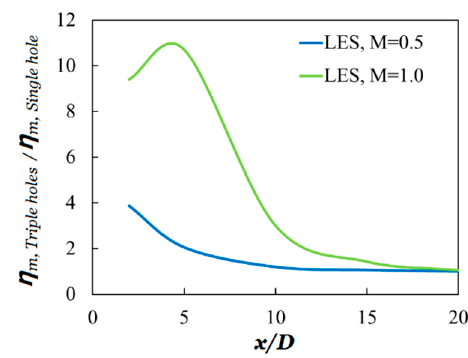
Figure 10. Ratios of spanwise-averaged effectiveness in the triple hole system to those in the single-hole system.